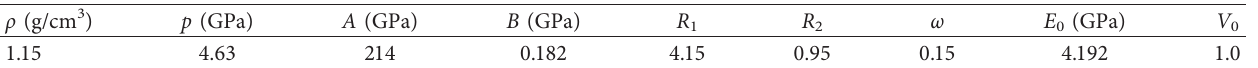
Table 4: Parameters of the